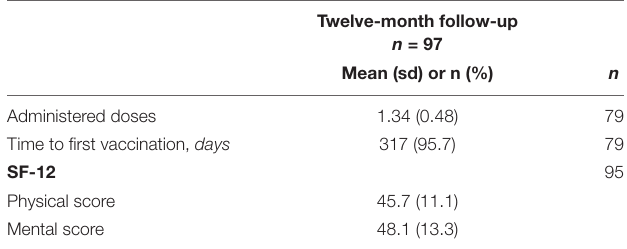
TABLE 3 | Prevalence of persistent symptoms and post-COVID syndrome at the 1-year